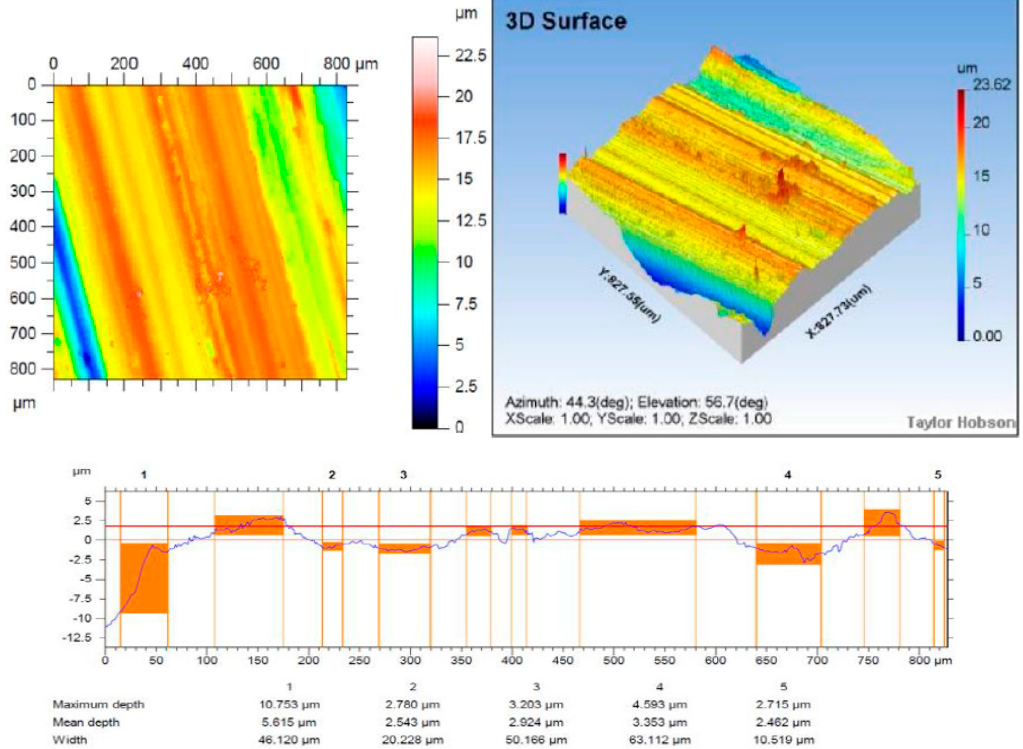
Figure 9. 3D laser profiling of AISI 410 cladded EN 8 pin after pin on disc.